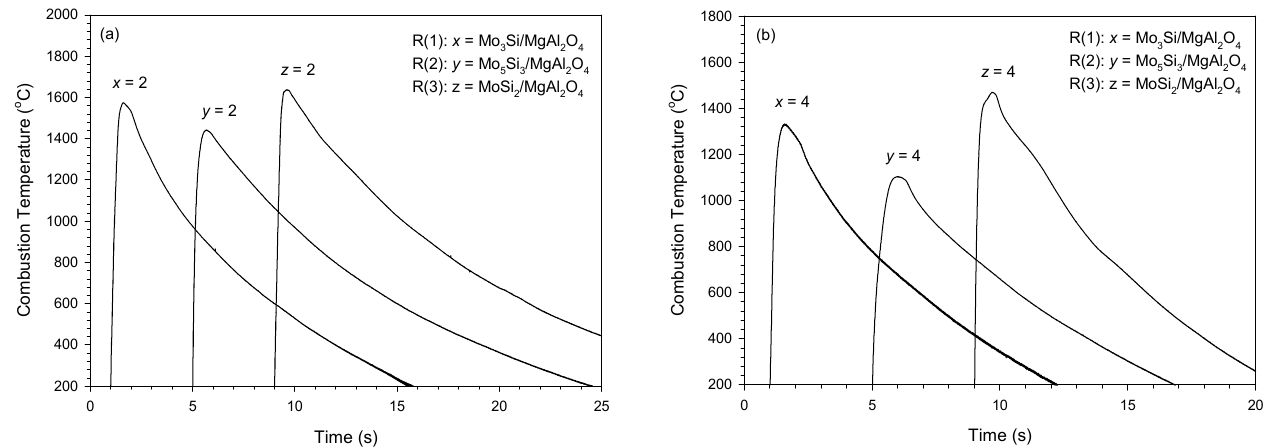
Figure 4. Combustion temperature profiles of R(1), R(2), and R(3) with stoichiometric coefficients of ( a ) x = y = z = 2 and ( b ) x = y = z = 4.